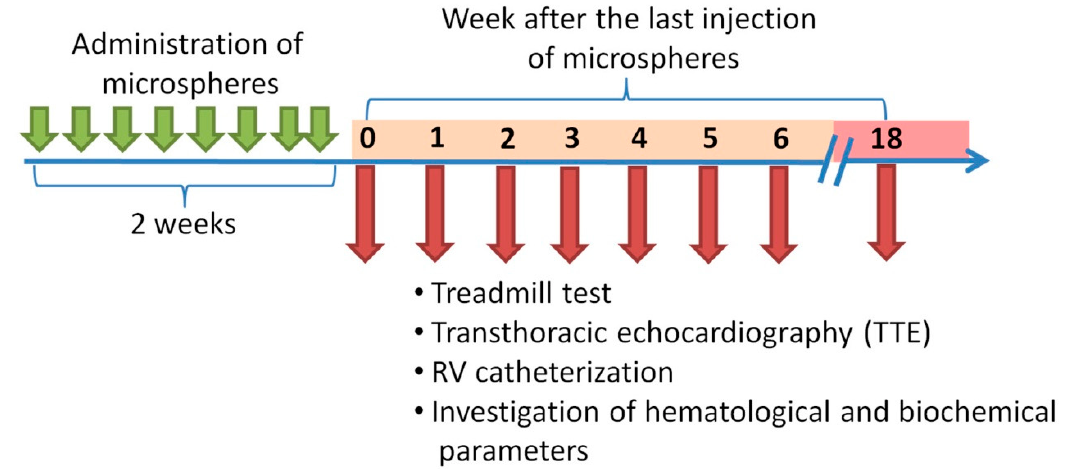
Figure 7. Scheme of experiment.